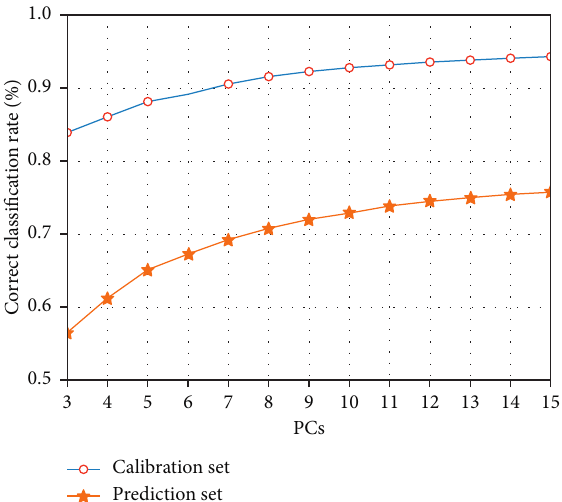
Figure 2: The CCR of MSC-PCA-KNN model with different numbers of principal